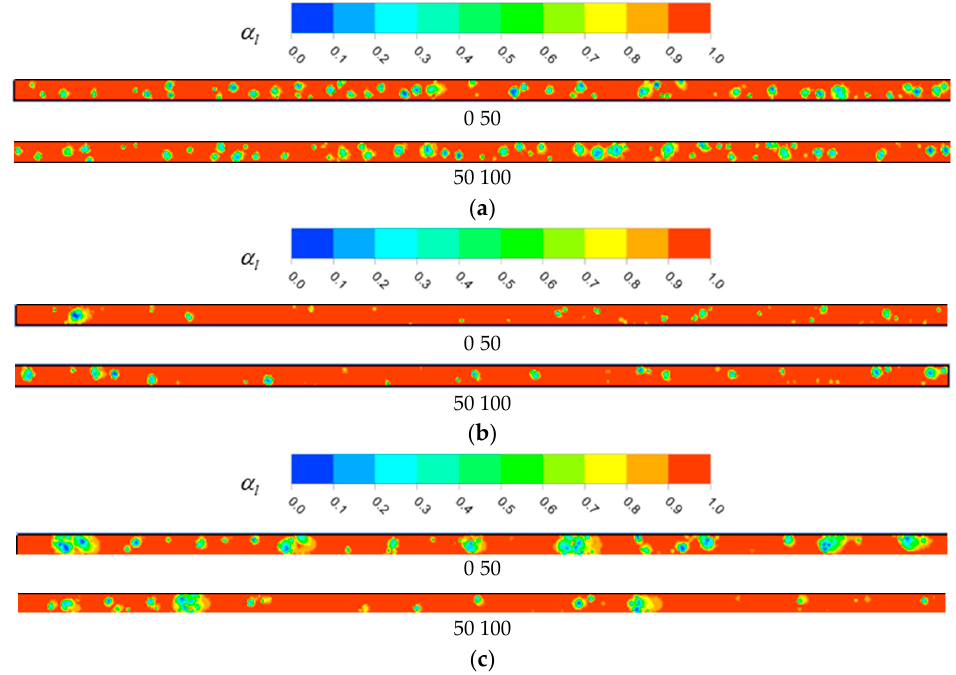
Figure 7. Volume fraction distribution of az-refrigerant liquid phase at different mass fluxes: ( a ) T sat = 253 K, G = 50 kg/m 2 s, q = 10 kW, X = 0.26; ( b ) T sat = 253 K, G = 75 kg/m 2 s, q = 10 kW, X = 0.18; ( c ) T sat = 253 K, G = 100 kg/m 2 s, q = 10 kW, X = 0.13.